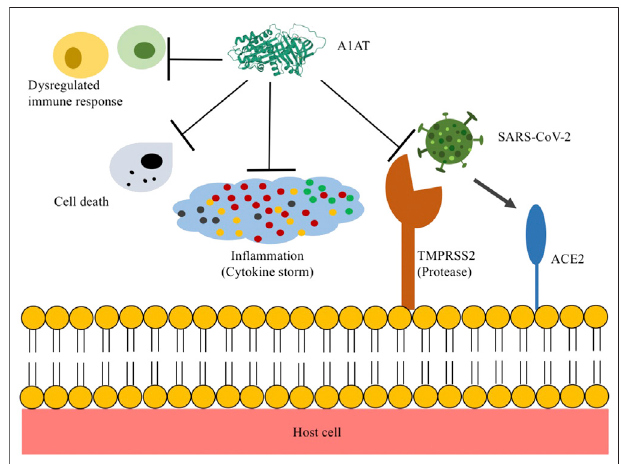
FIGURE 1 | Proposed mechanisms of alpha-1 antitrypsin (A1AT) in COVID-19 treatment. The entry of SARS-CoV2 into host cells is through the binding of viral S-protein to angiotensin converting enzyme 2 (ACE2) located on host cells, which is mediated by the transmembrane serine protease 2(TMPRSS2).A1ATinhibitsTMPRSS2,thus,reducesSARS-CoV-2infection. In addition, A1AT can reduce acute in fl ammatory responses, cell death, neutrophil elastase trap formation, coagulative activity, and dysregulated immune